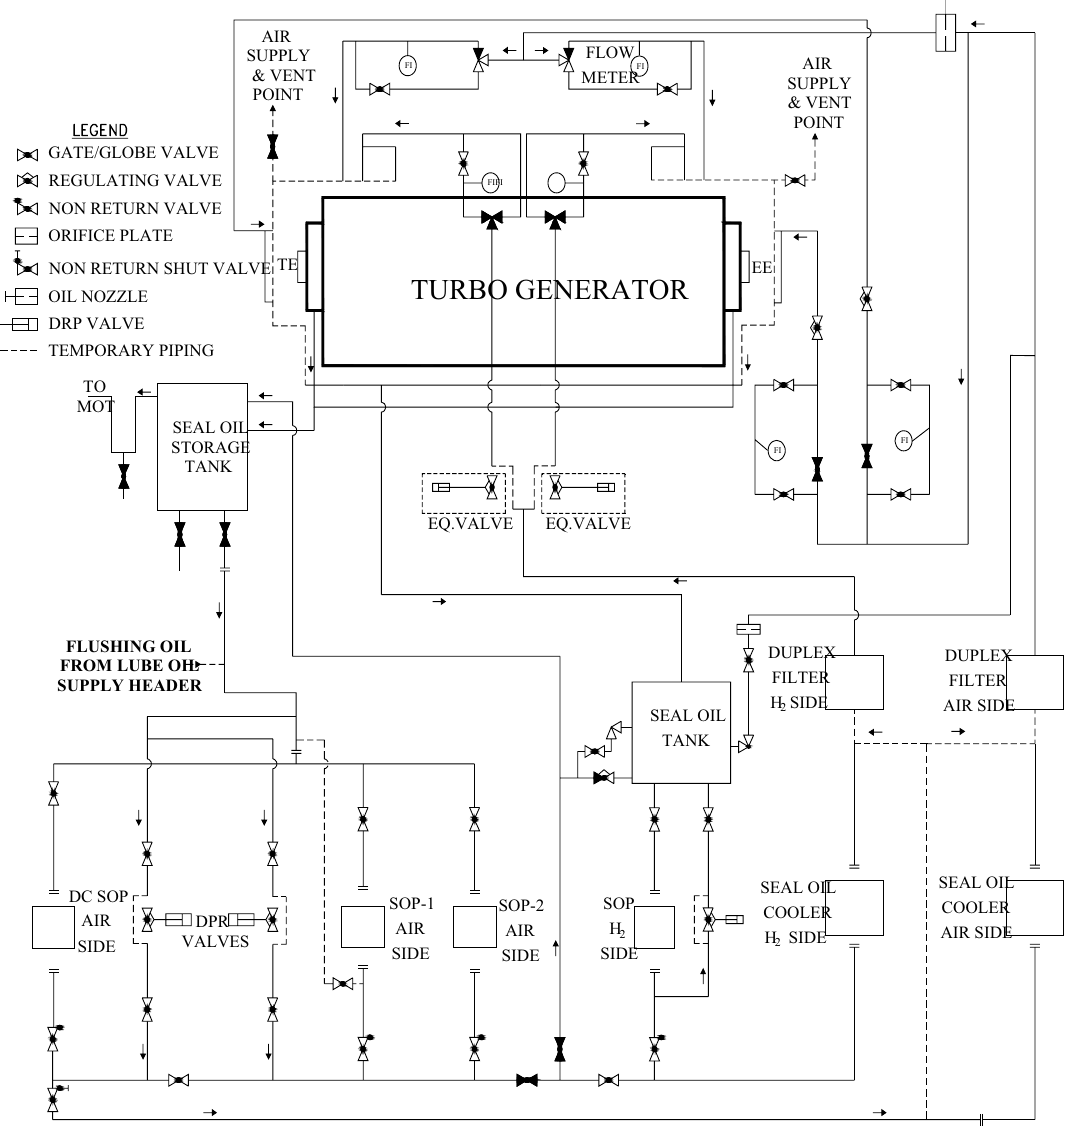
Fig. 3 Flushing scheme of seal oil system